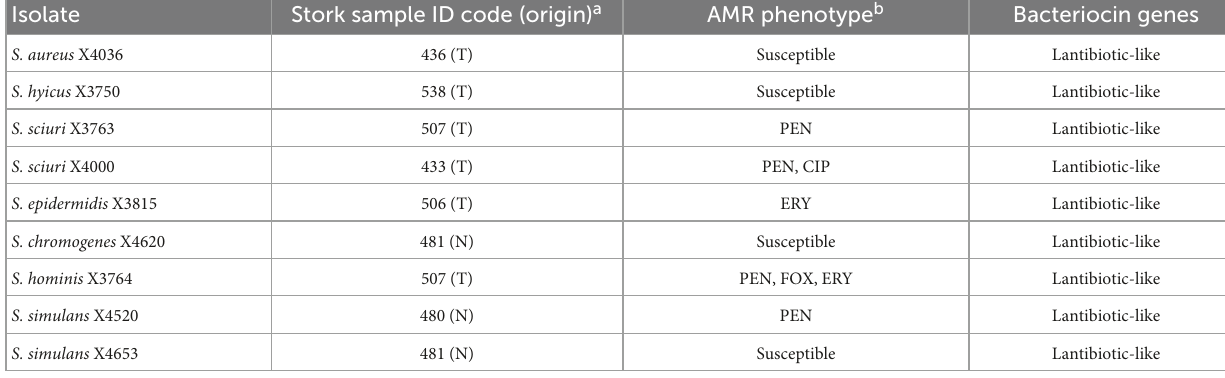
TABLE 4 Characteristics of the nine antimicrobial producer isolates of the nasotracheal microbiota of